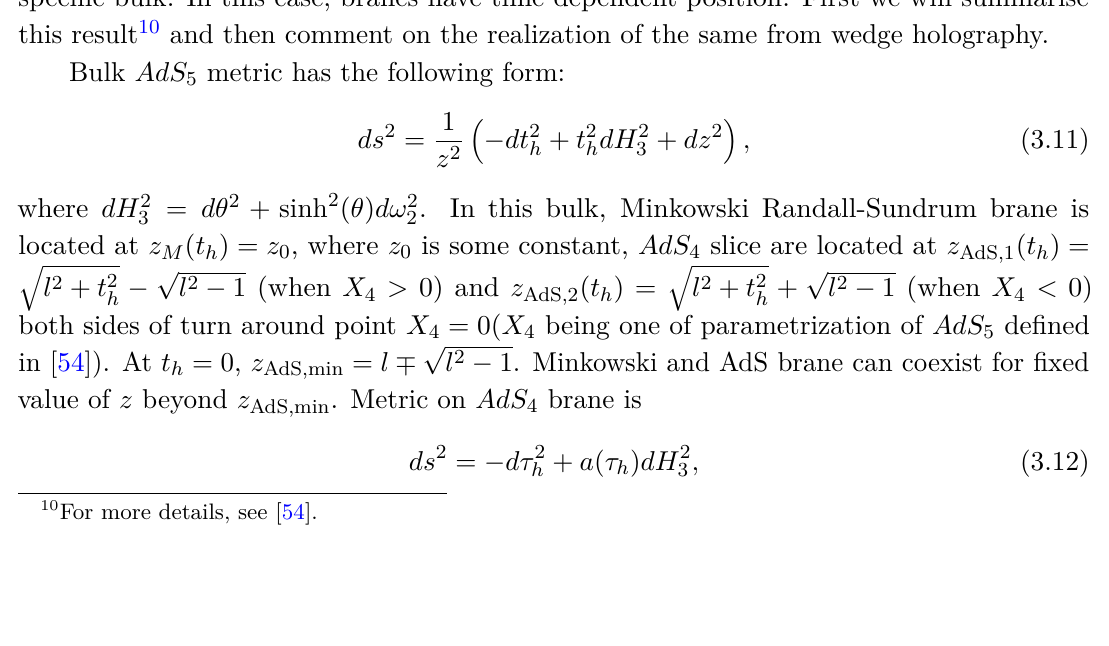
= n = 3 to draw this 1 2